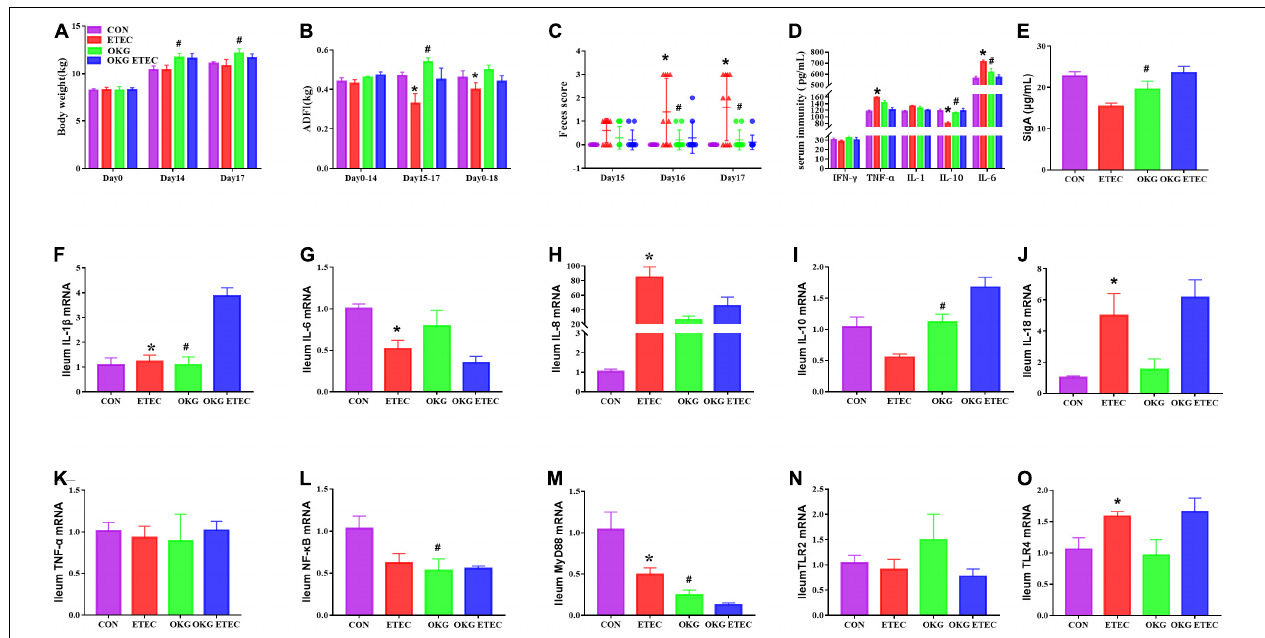
FIGURE 1 | Effects of OKG supplementation on growth performance, feces score, and serum and small intestinal immunity in ETEC- infected pigs. (A) Body weight (kg), (B) average daily feed intake (kg), (C) feces score, (D) serum immunity (pg/mL), (E) ileum SIgA ( µ g/ml), (F–O) gene expressions of immunity in ileum. Values are presented as mean ± SEM. *Indicates a statistically significant difference for the challenge (ETEC or LB Broth) ( p < 0.05). # Indicates a statistically significant difference for dietary treatment (basal or OKG diet) ( p <